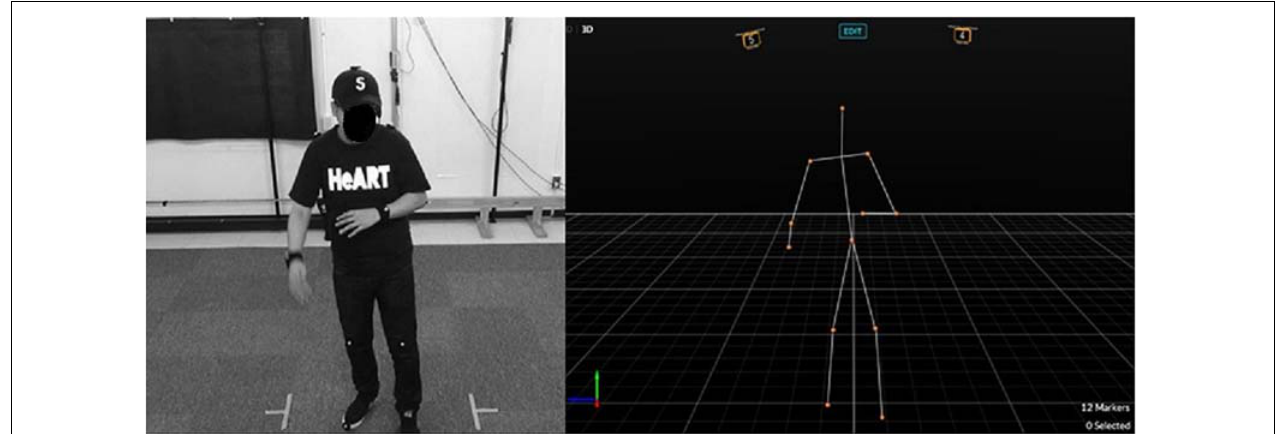
FIGURE 1 | An experimental situation and the motion capture system (from Kodama et al., 2019).